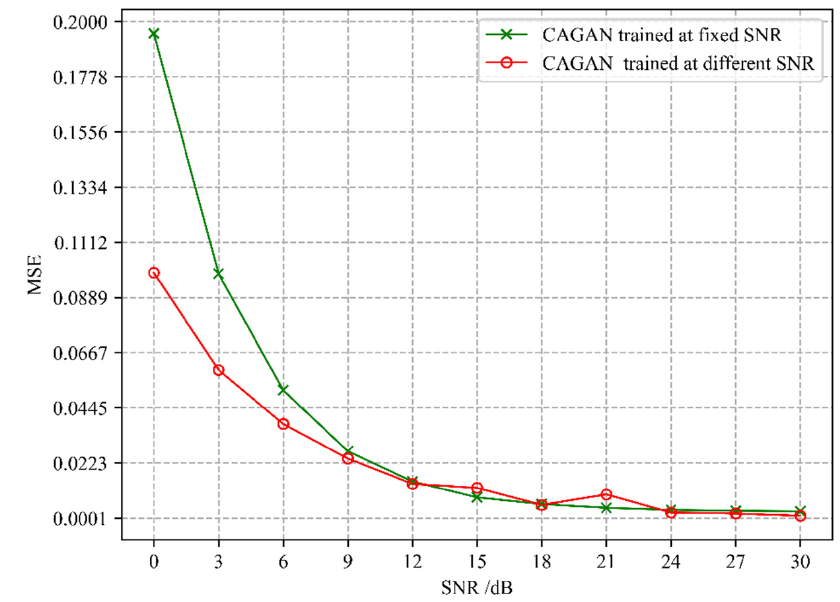
Figure 7. Performance comparison of CAGAN in two training modes.